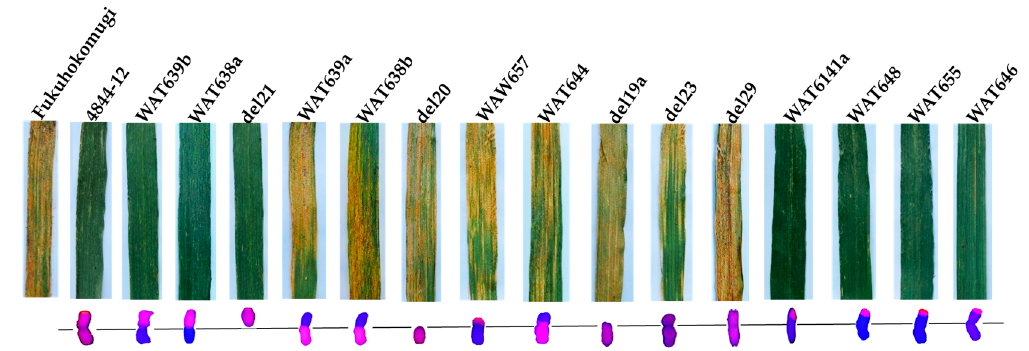
Figure 5. Evaluation of stripe rust resistance of wheat- A . cristatum 6P derivatives. GISH patterns: 6P